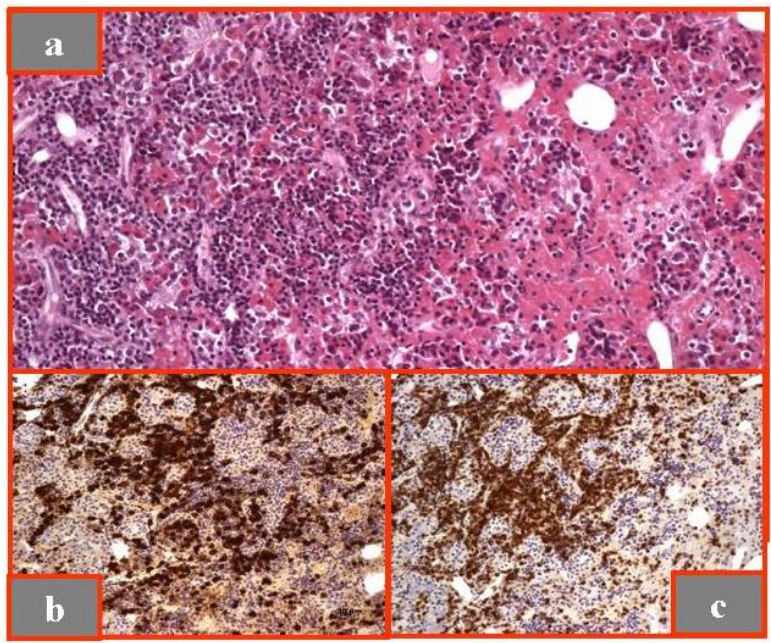
FIGURE 3. Histopathological detection showing extensive destruction of anterior pituitary acini with lymphoplasmacytic infiltration. (a) Lymphocytes and plasma cells infiltrate the parenchyma of the adenohypophysis (hematoxylin-eosin stain); (b) inflammatory infiltrate stained with lymphoid CD20-B cell marker; (c) inflammatory infiltrate stained with lymphoid CD3-T cell